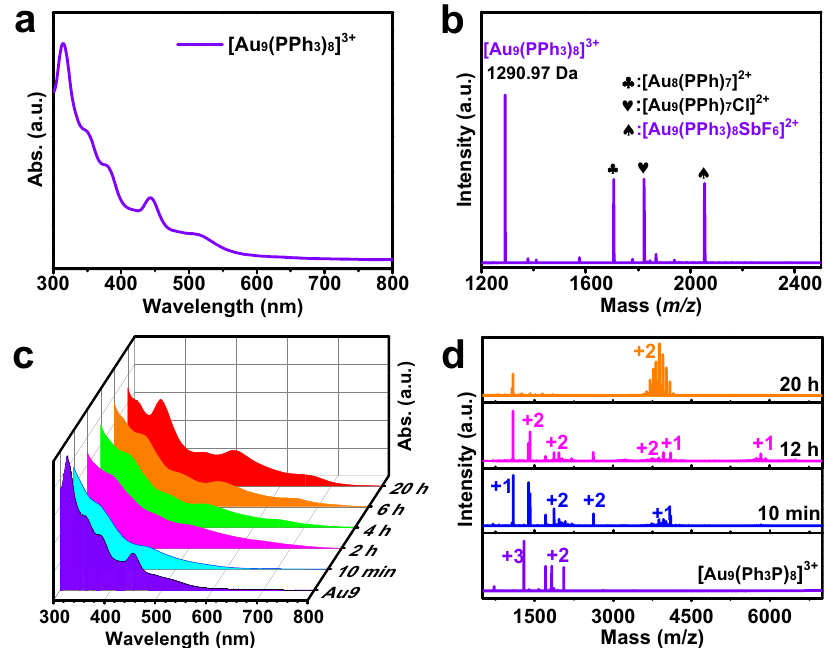
Fig. 1 The conversion of Au 9 to Au 12 Cu 13 clusters. a UV-vis spectrum (in CH 2 Cl 2 ) and b positive ion mode ESI-MS of Au 9 cluster. Conversion of Au 9 to Au 12 Cu 13 clusters monitored by c time-dependent UV-vis spectra and d time-dependent